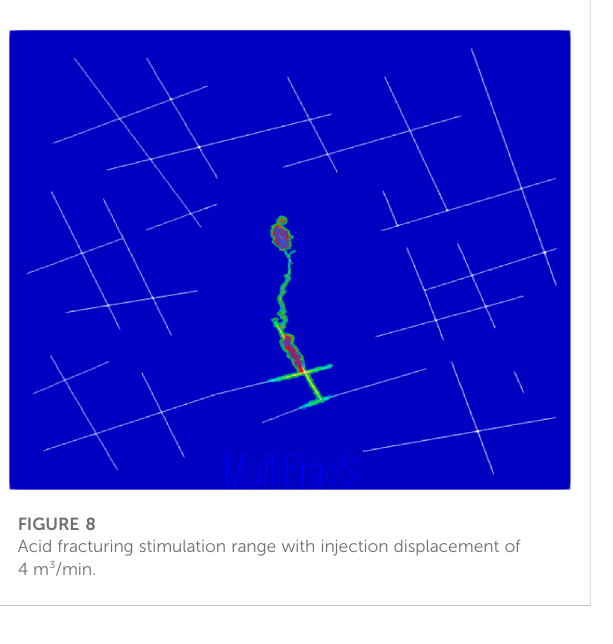
FIGURE 10 Acid fracturing stimulation range with injection displacement of 8 m 3 /min.